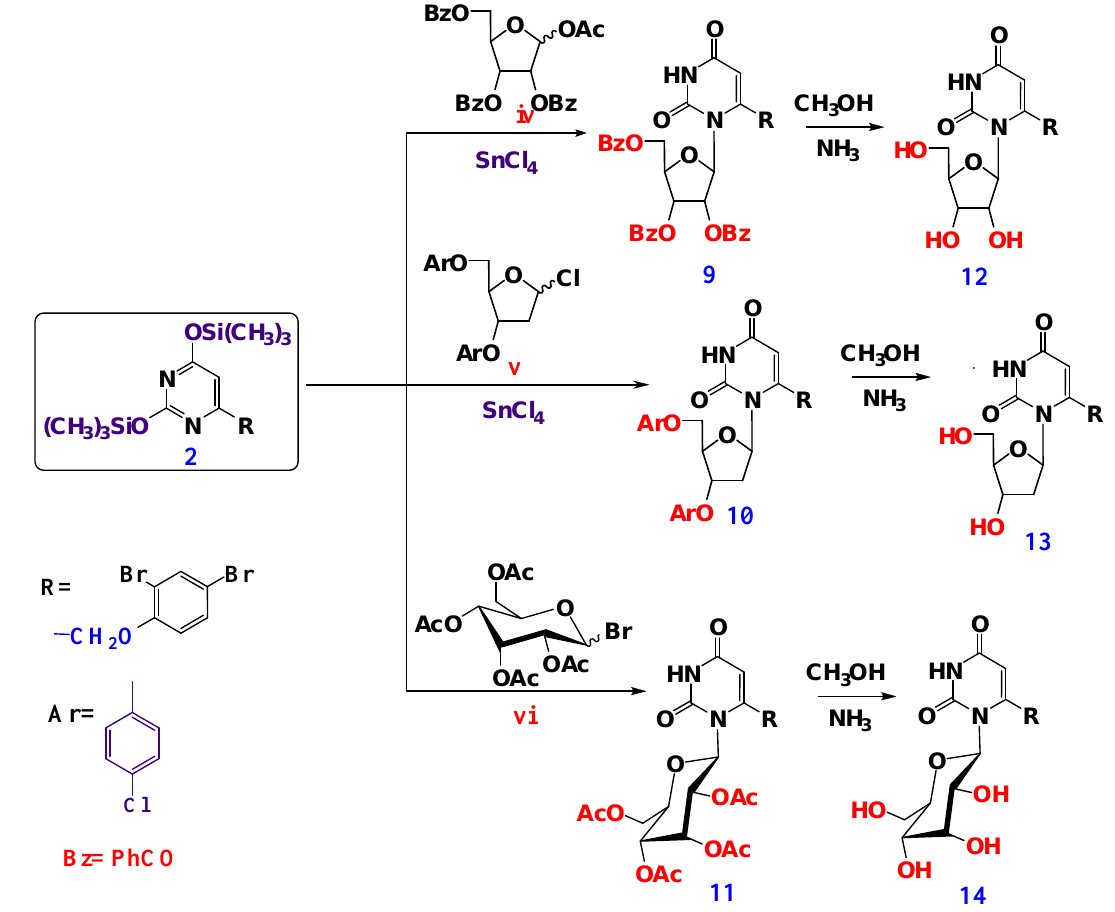
Table 1. Inhibition of HSV-1-related CPE using different concentrations of tested compounds and a standard drug (ACV). ti a r n t e c n o C o